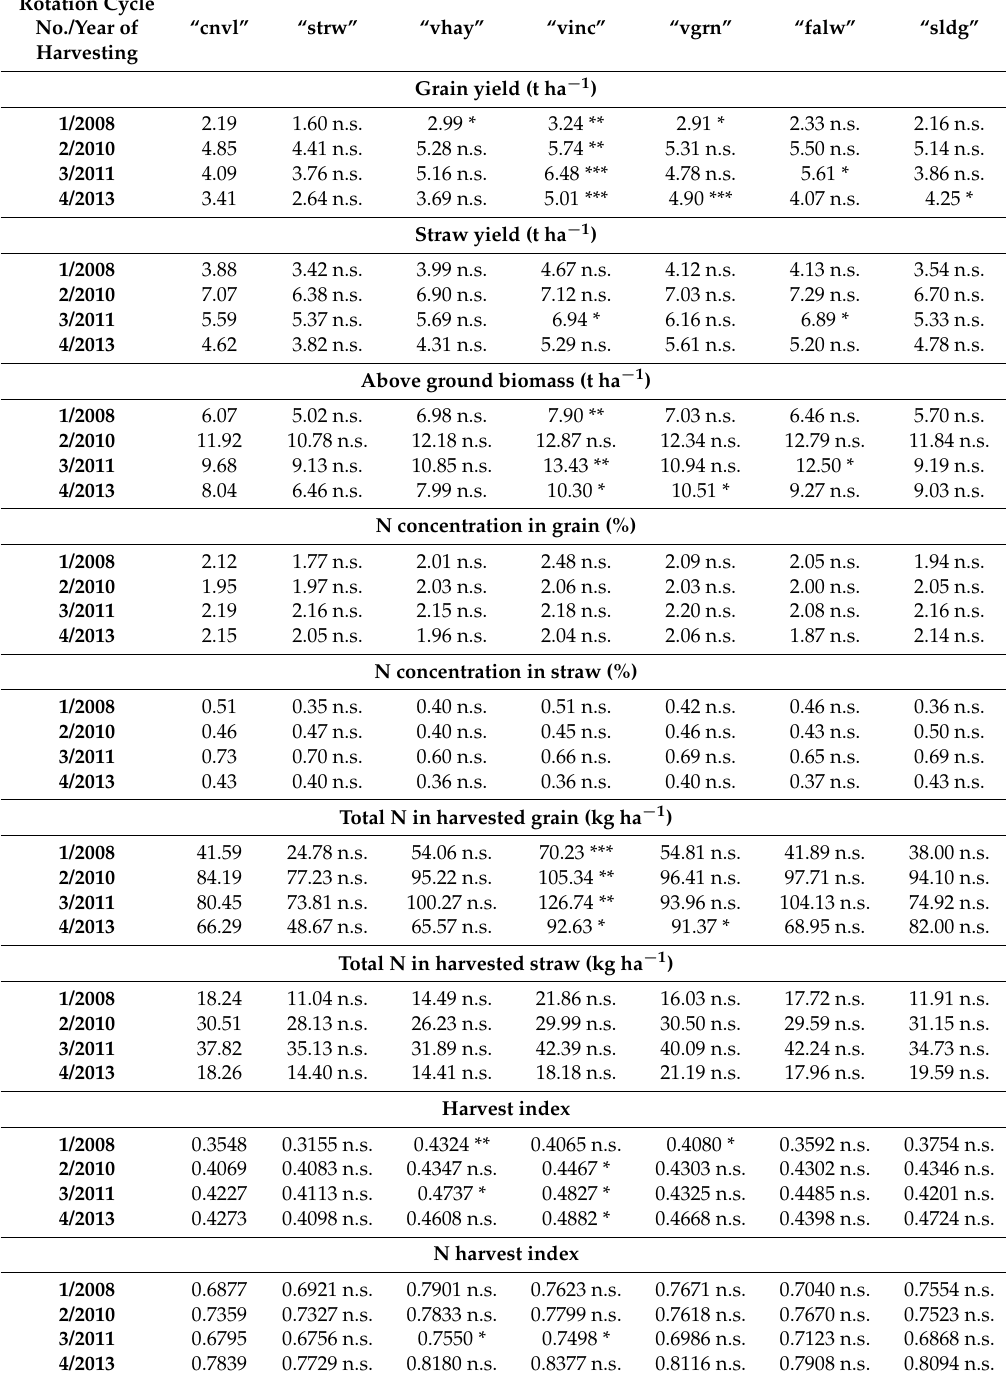
Table 2. Treatment effects on wheat yields and N concentration and uptake at the second year of each rotation cycle (“test years”). Statistical analysis results displayed at the right side of values refer to the comparison between treatments and the